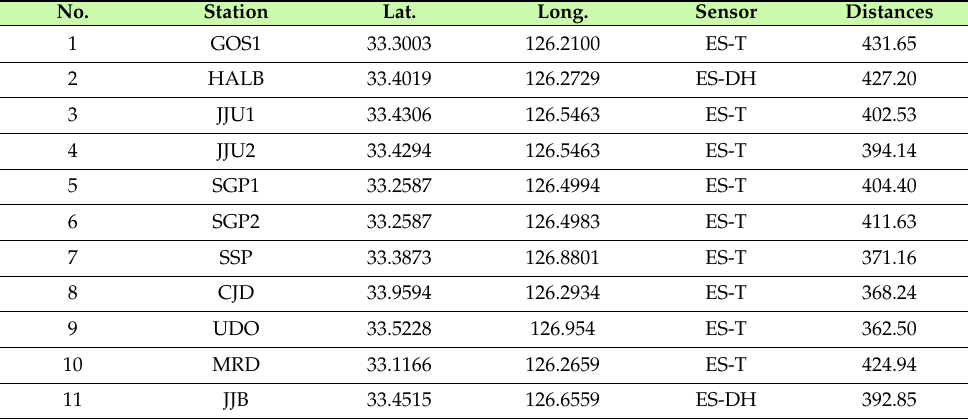
Figure 1. Locations of the Kumamoto earthquake series (red circles), Pohang earthquake series (red circles), and the 11 seismic stations (green triangles). Table 2. Seismic stations and their distances from the epicenter of the main event.